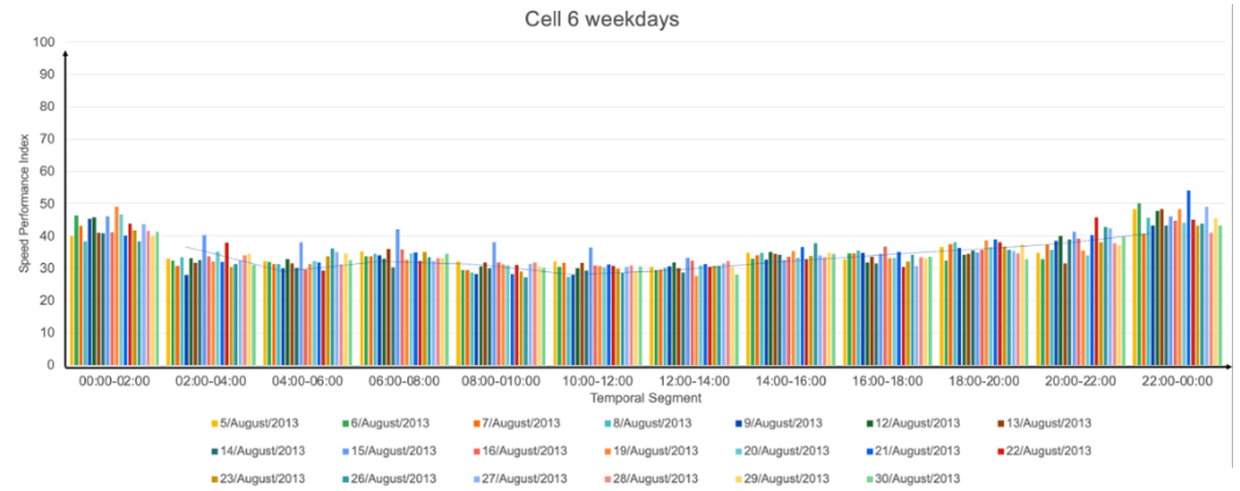
Figure 17. Calculated SPI for the weekdays, cell 6 with Vmax = 100